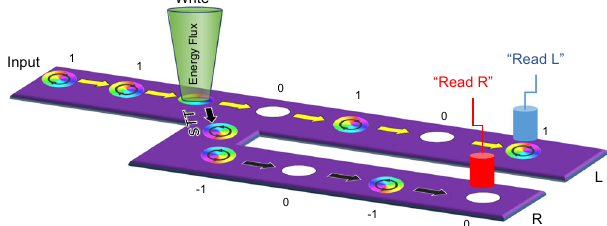
Fig. 5 | A schematic diagram of a racetrack memory method using the DDI skyrmion. The bubbles with uniform chirality move under an electonic beam whichcanchangethein-planeswirlingofthosebubbles.ThenSTTeffectseperates those bubbles to diffferent sides of the track and two sensors may read the cor- responding spin texture as the desired signal